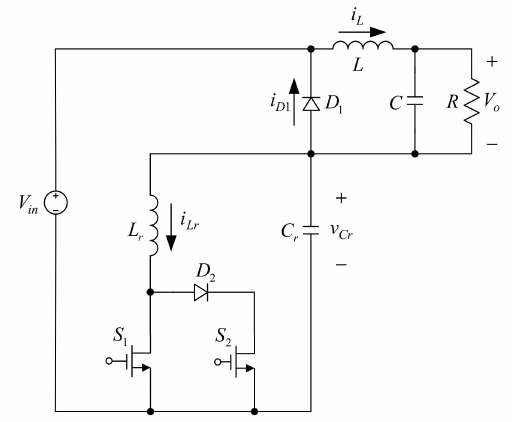
Figure 1. Proposed resonant buck converter.